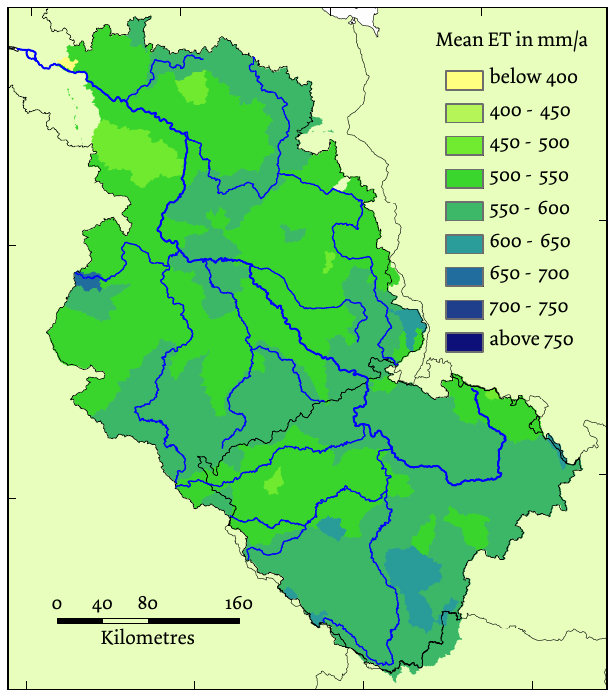
Fig. 9. Evapotranspiration patterns in the Elbe River basin accord- ing to SWIM. Average values for 133 sub-basins for the years 2001–